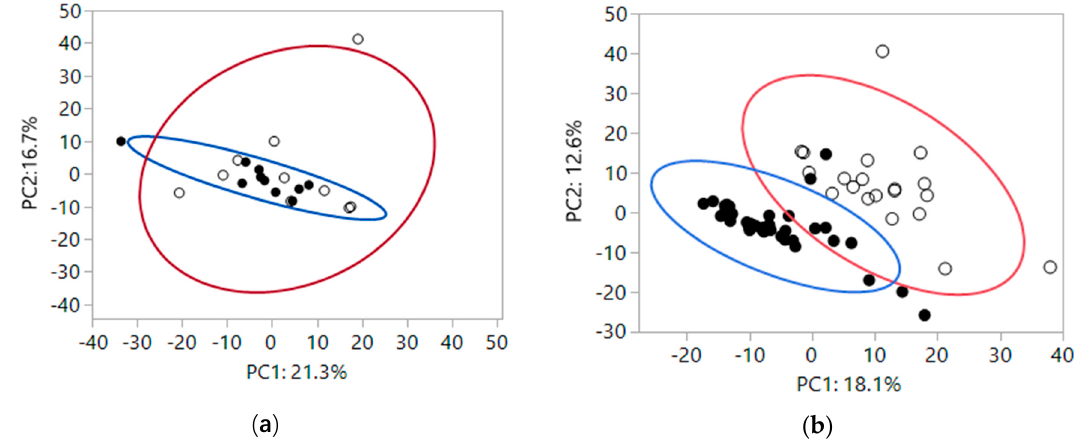
Figure 1. (a) At baseline fecal metabolites of healthy cats (closed circles) and chronic kidney disease (CKD) cats (open circles). Large colored circles represent 95% variance areas of healthy (blue) and CKD cats (red). The means of PC1 and PC2 were not significantly different (PC1, P = 0.25; PC2, P = 0.61). Variances were also not significantly different based on health status (PC1, P = 0.38; PC2, P = 0.10). (b) Fecal metabolites after feeding scFOS or apple pomace fiber sources for 4 weeks (closed circles) vs baseline (open circles). Large colored circles represent 95% variance areas at baseline (red) and after feeding fiber sources (blue). The means of PC1 and PC2 after feeding dietary fiber for four weeks were different (both P < 0.0001). Variances were not significantly different between baseline and after feeding fiber sources for 4 weeks (PC1, P = 0.75; PC2, P = 0.10).